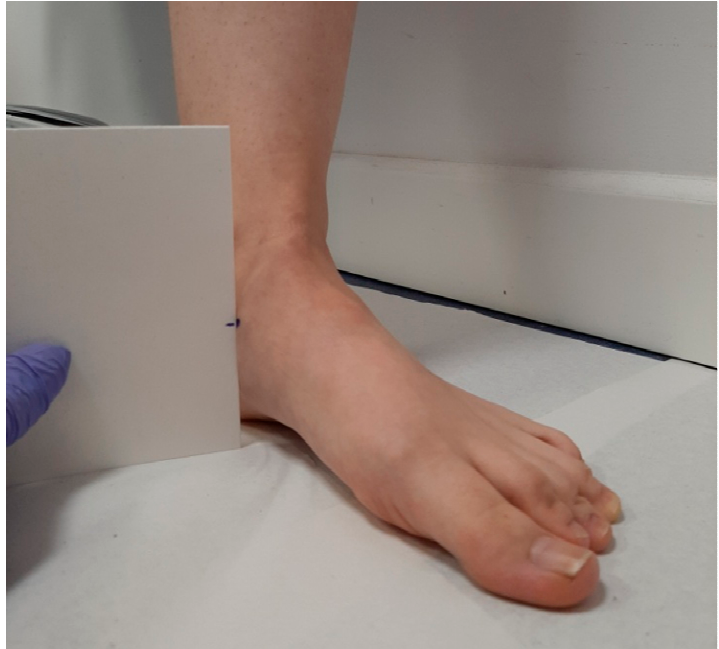
Figure 2. Measurement of the height point marked in the most prominent aspect of the medial tuberosity of the navicular bone with a neutral position of the foot.